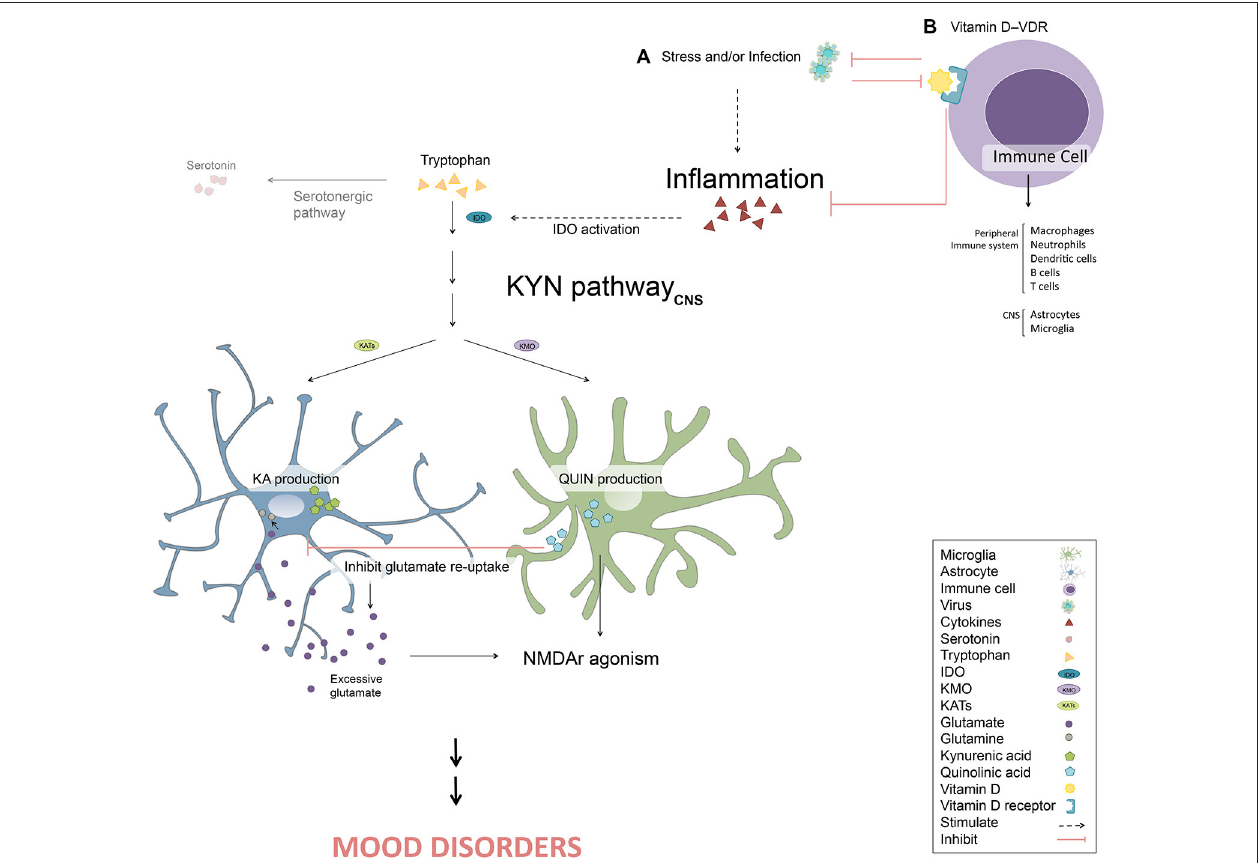
glutamate re-uptake, resulting in excessive extracellular glutamate, inducing further NMDAr agonism. Excessive NMDAr activation leads to the disruption of the glutamatergic system, a key pathological feature in mood disorders. (B) The binding of vitamin D to VDR in a number of immune cells (e.g., macrophages, neutrophils, dendritic cells, B cells, T cells, astrocytes and microglia) leads to attenuation of the inflammatory response and stimulation of anti-microbial peptides production, potentially ameliorating symptoms of mood disorders. However, certain pathogens can also block or modulate epigenetic VDR